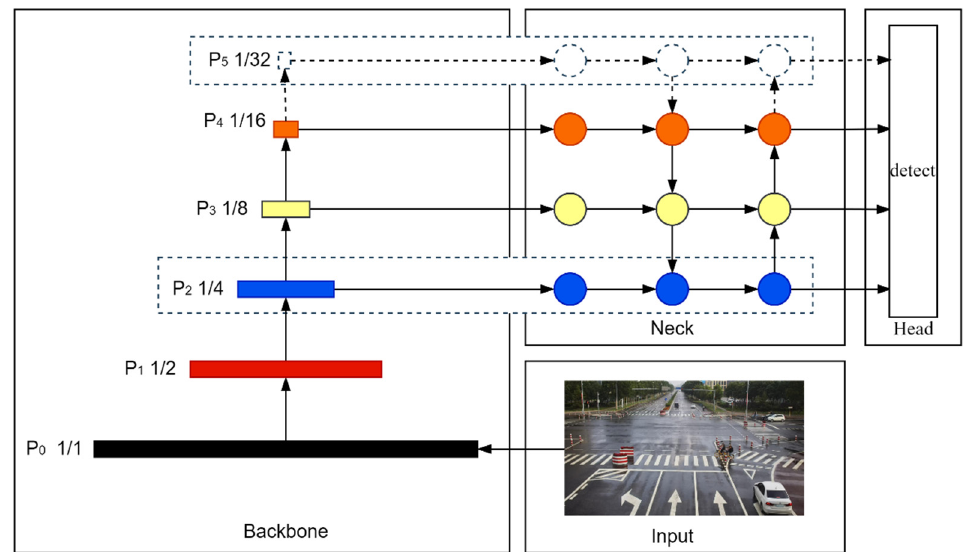
Figure 3. The network architecture of the improved feature fusion layer. The 32 × downsampling feature fusion layer is removed. The 4 × downsampling feature fusion layer is added.